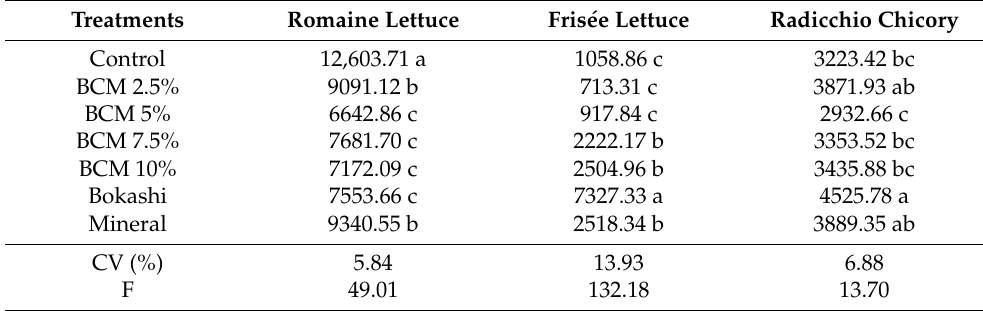
Table 5. Means of nitrate content mg kg − 1 in dry weight of fris é e and romaine lettuce, and radicchio chicory submitted to different concentrations of boiled chicken manure (BCM), bokashi, and mineral fertilization in a greenhouse. Londrina, Paran á State, Brazil,